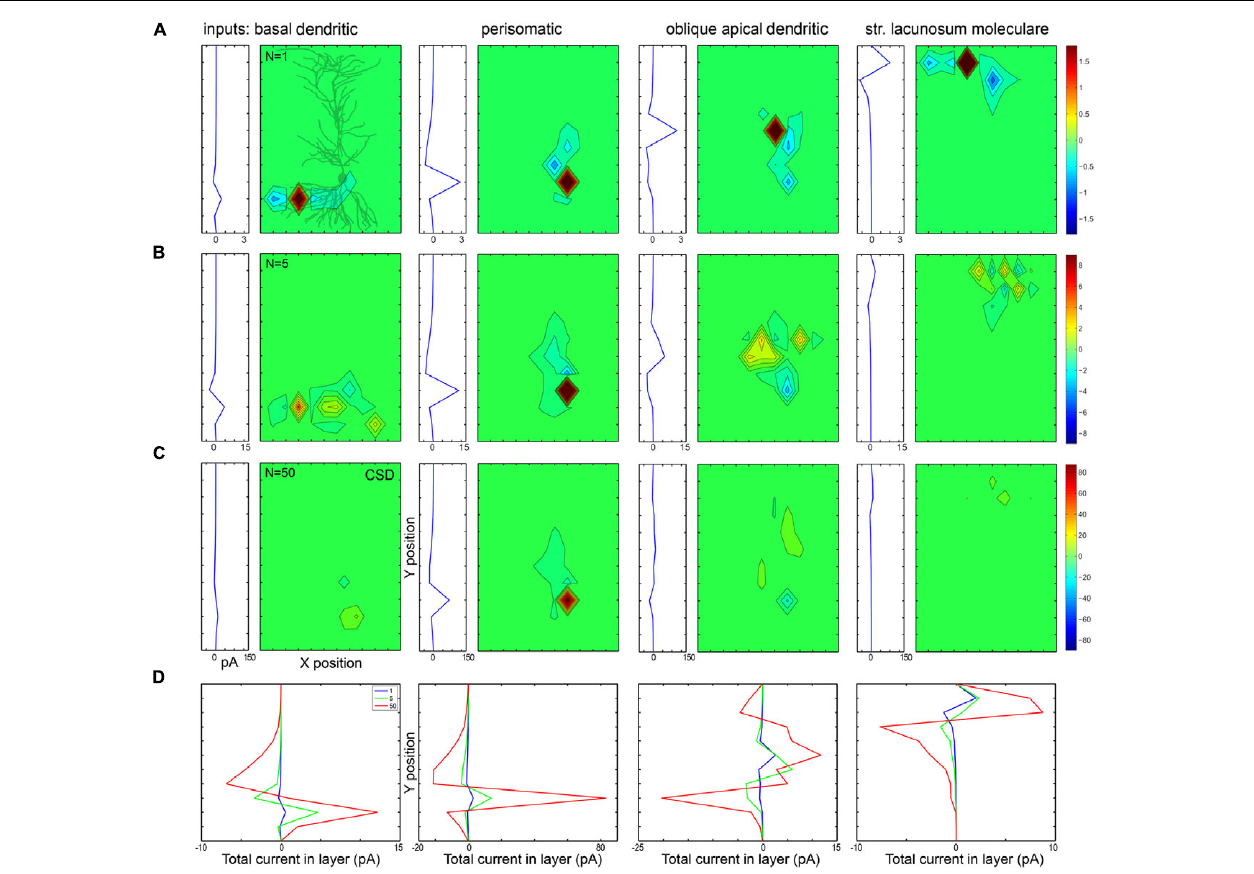
FIGURE 10 | Passive and active currents cancel when many synaptic inputs are distributed over the dendrites. (A) When a single conductance is placed on different somato-dendritic compartments, the strong active current is surrounded by weaker passive currents spread out according to the orientation of dendrites. In each block the left graph shows currents recorded by a simulated electrode array from different layers, while the right (mostly green) panel shows the CSD in 2D (along the X - and Y -axes). In the first block a 2D projection of the modeled PC is shown in gray. (B,C) When synaptic inputs are scattered according to anatomical rules over the dendrites, the active currents of one input are canceled by the passive currents of the other inputs. In the case of 50 inputs (C) the cancelation is stronger than for five inputs (B) . For the centrally located, dense perisomatic inputs active and passive currents are consistently located within the same region and thus sum, resulting in a substantially stronger LFP signal than for the dendritic inputs. The scales are the same for all panels in a single row, and are changed in proportion to the number of inputs across rows. Numbers indicating color scales are in pA. (D) These panels compare the CSD depth profiles (shown individually in panels A–C ) for different numbers of synaptic input (1, 5, or 50) to specific parts of the cell. Note the strongest summation for the perisomatic inhibition and canceling interactions for dendritic locations.